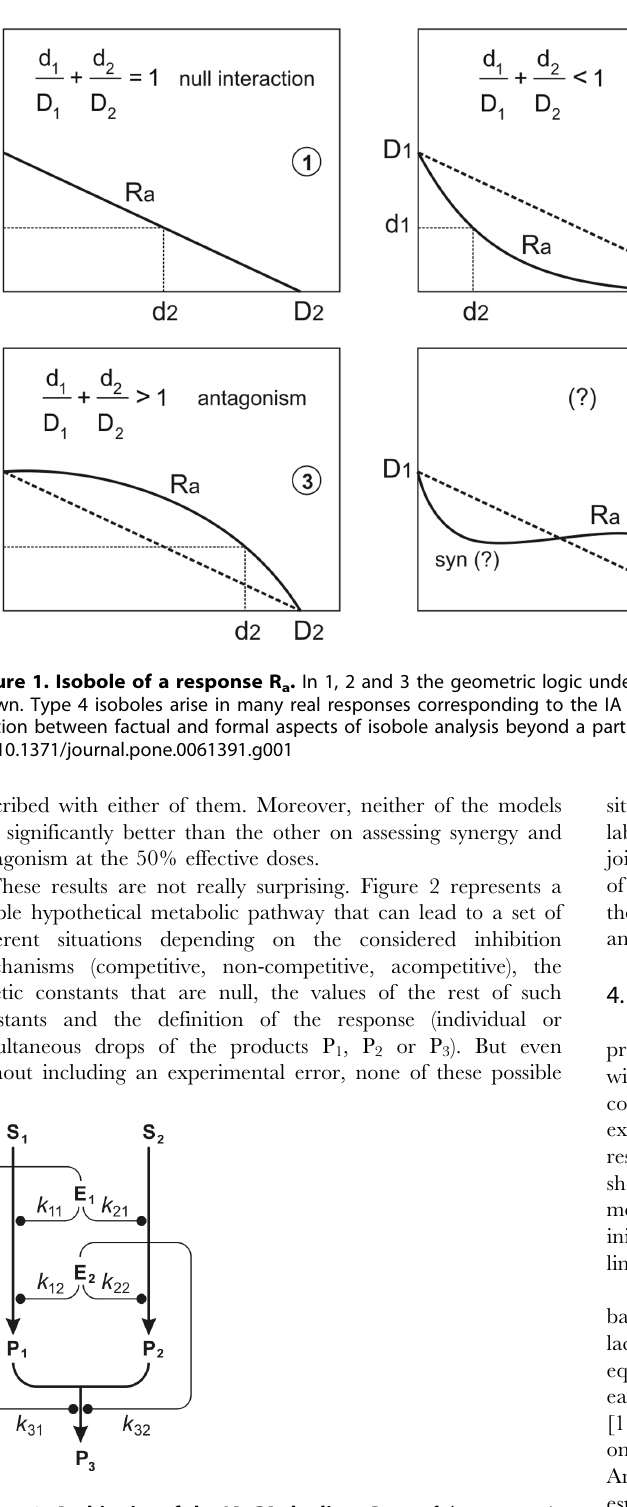
Figure 2. Ambiguity of the IA-CA dualism. Rates of the enzymatic reactions yielding products P 1 to P 3 from substrates S 1 and S 2 are affected by the inhibiting effectors E 1 and E 2 with the specified inhibition constants k ij . Under these conditions, responses measured as drops of the levels of any of the products are dependent of the nature (competitive, non-competitive, acompetitive) of the inhibition and the values of the inhibition constants. But any result can be unambiguously attributed to IA or CA modes of action.